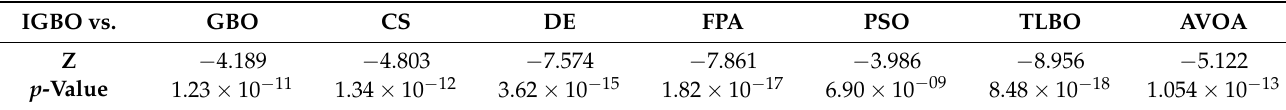
Table 7. Wilcoxon Signed Ranks test for multimodal benchmark functions.